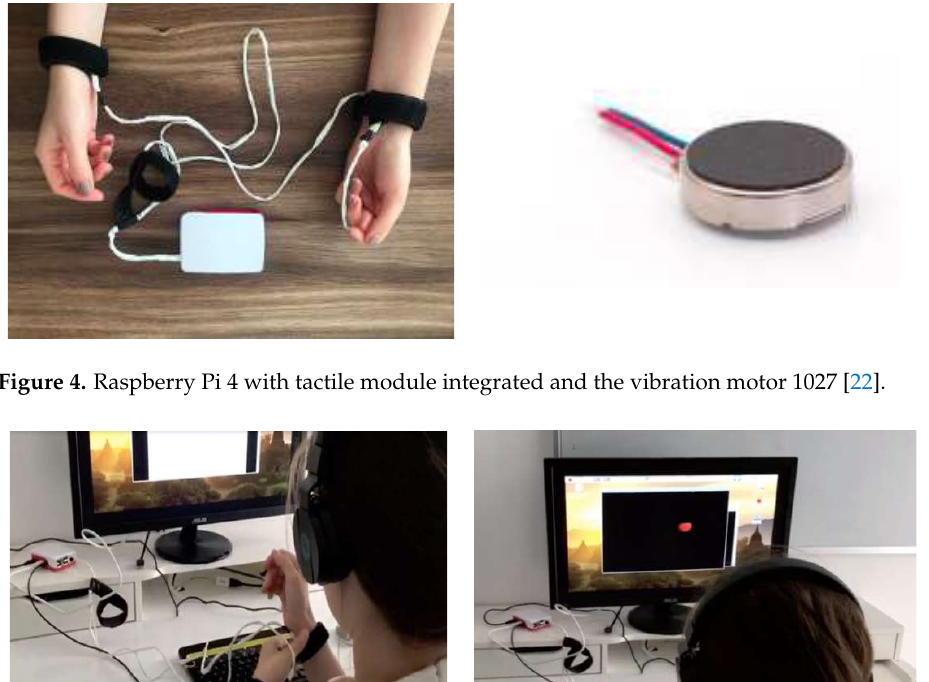
Figure 4. Raspberry Pi 4 with tactile module integrated and the vibration motor 1027 [22].